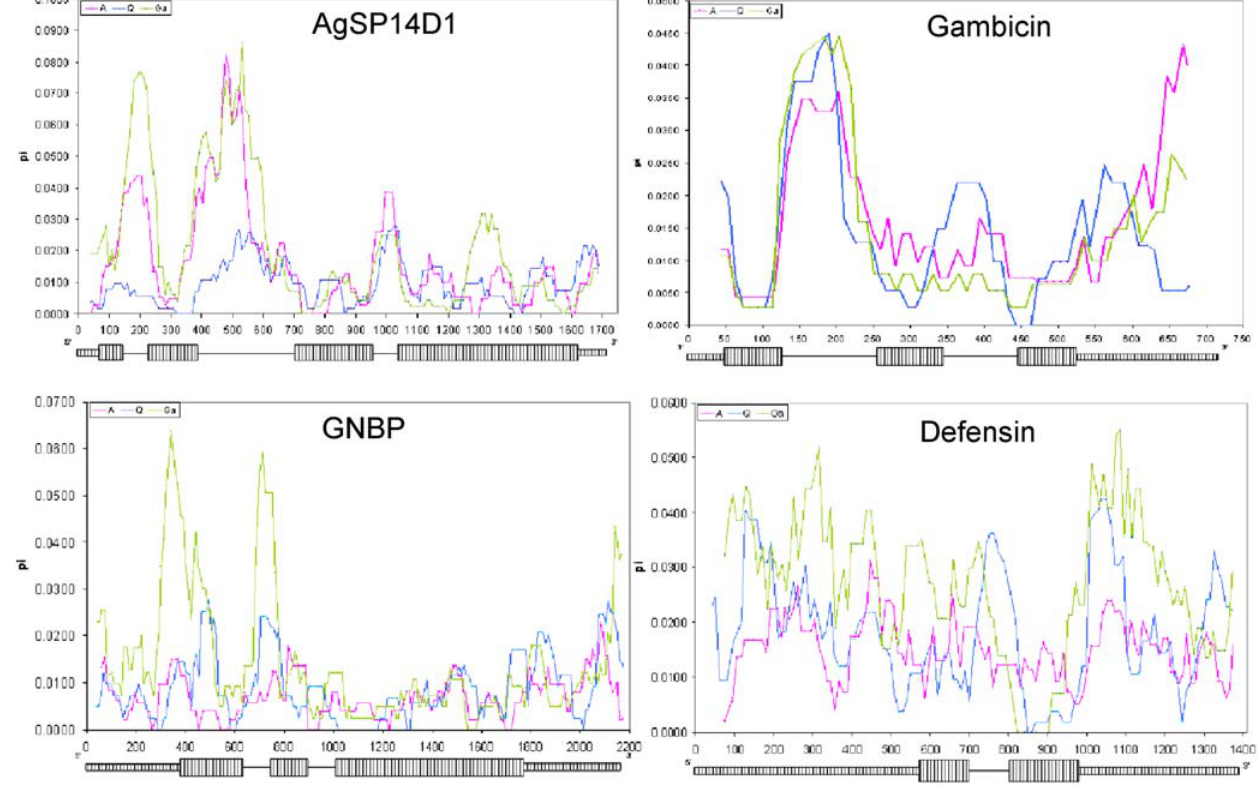
Figure 2. Polymorphism along the gene using sliding window (window length=50 bp; sliding interval=10 bp). Exons and flanking regions are denoted by broad and narrow hatched rectangles, respectively; introns are denoted by lines. A, Q, and Ga denote An. arabiensis , An. quadriannulatus , and An. gambiae from western Kenya, respectively.